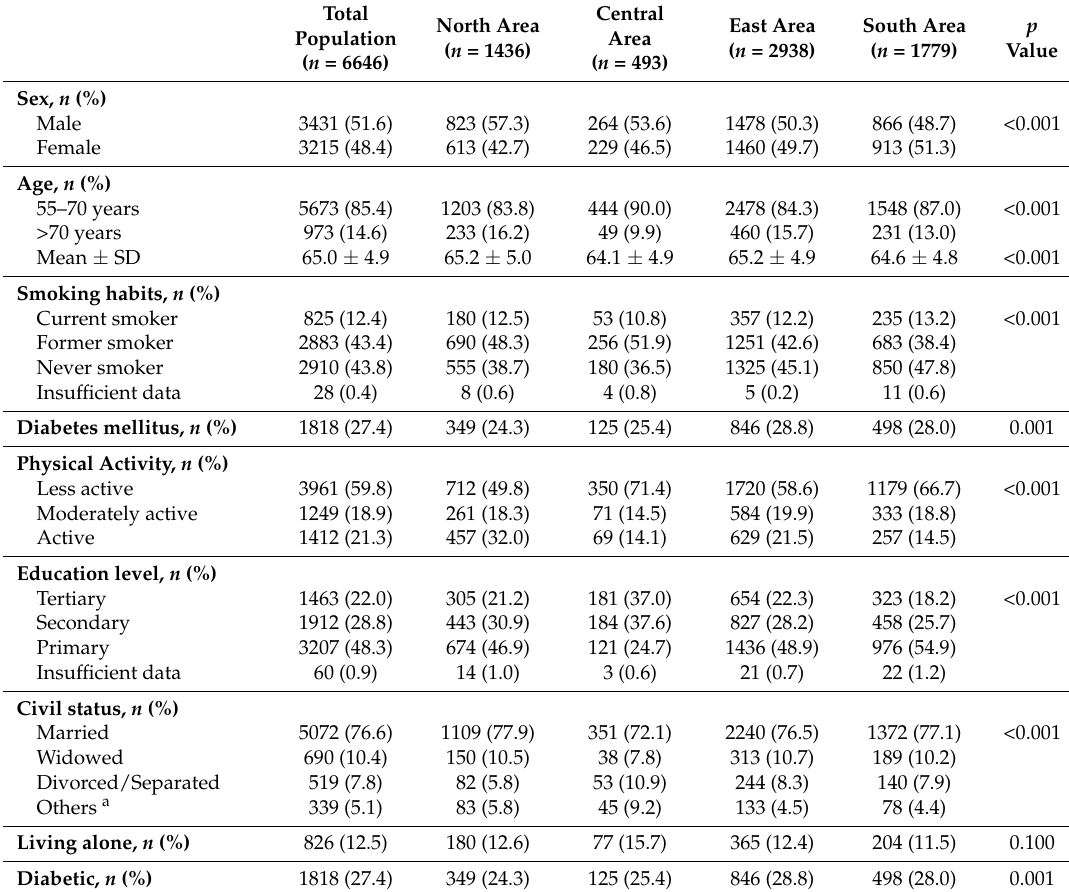
Table 1. Baseline characteristics of the PREDIMED-Plus study participants by geographical areas (total population n =